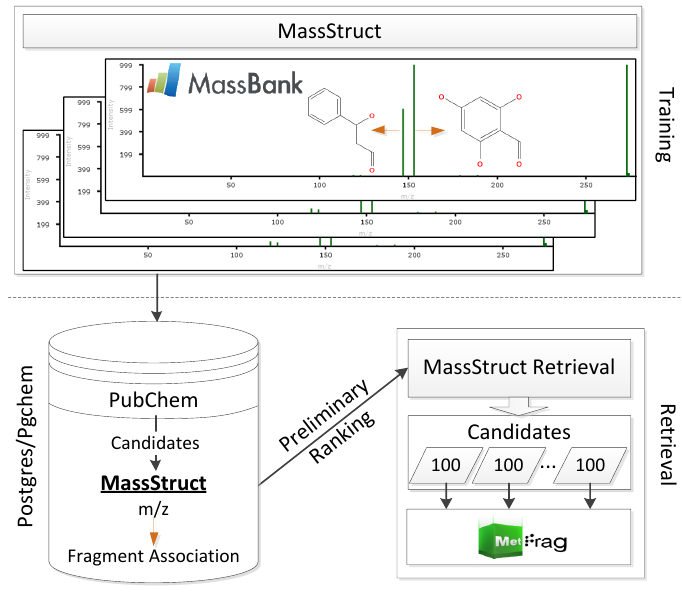
Figure 2: The training step (top) shows the MassBank spectra and the fragments predicted with MetFrag. The peaks annotated with a fragment structure are stored in the MassStruct database (lower left). In the operation phase the stored m/z → structure associations are used to retrieve the ordered candidates in batches of e.g. 100